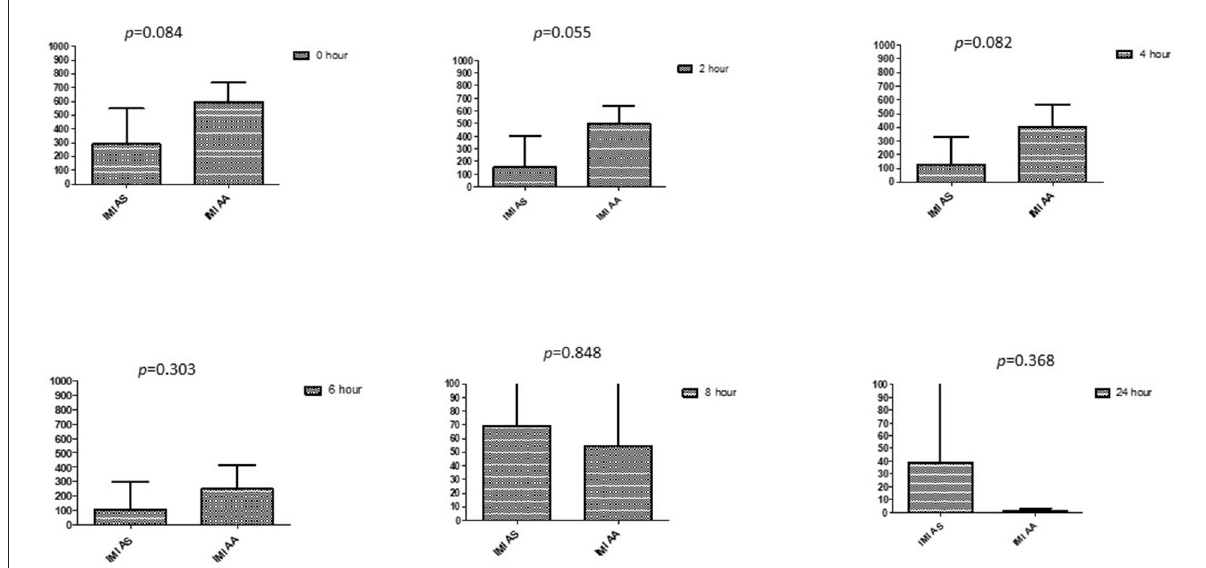
FIGURE7 Comparison of imipenem’s minimum inhibitory concentrations ( µ g/mL) when combined with AA and AS on E. coli. IMI-AS, Imipenem combined with AS; IMI-AA, Imipenem combined with AA; p < 0.05 indicate a significant difference among MICs of antibiotic combined with AS and AA.